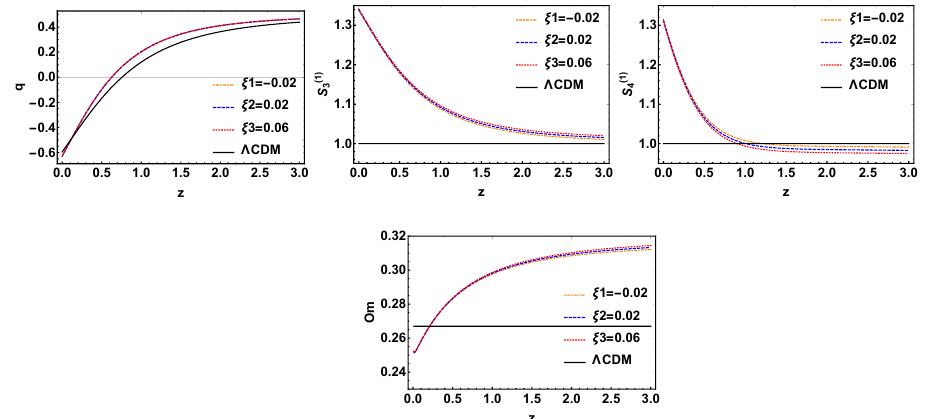
( 1 ) ( 1 ) , S and Om , respectively, versus red shift z for the 3 4